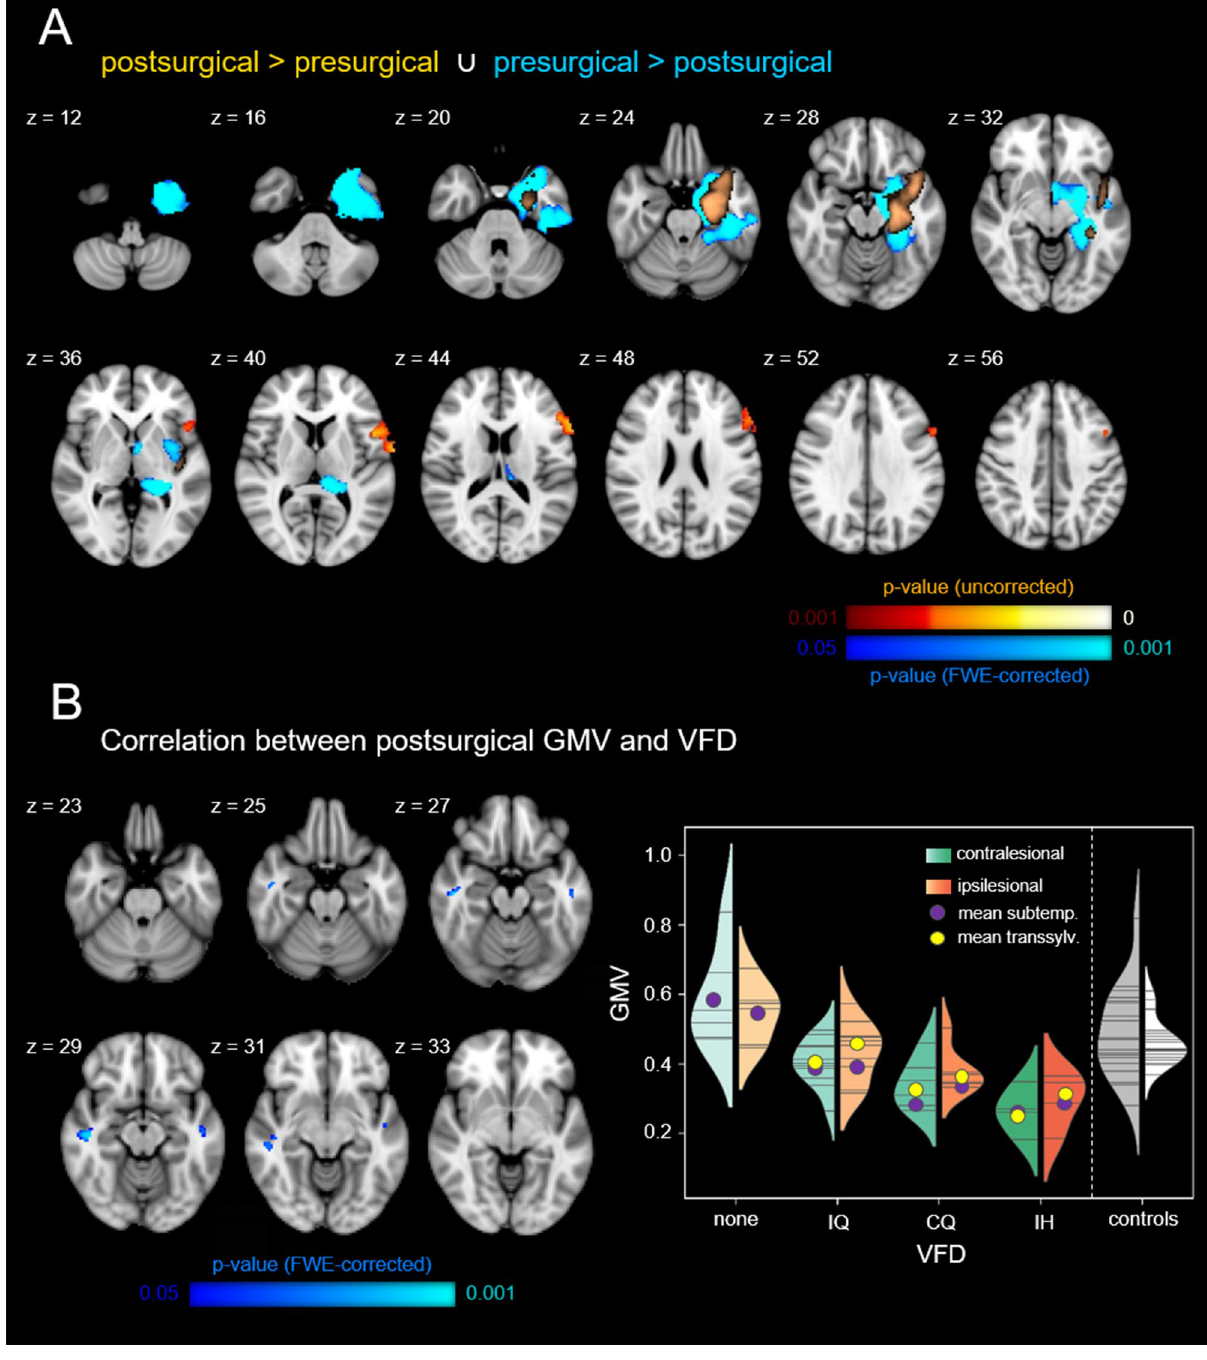
Figure 2. Voxel-based morphometry results. ( A ) Gray matter volume comparison of pre- and postsurgical T1-weighted scans of the transsylvian patient subgroup (FWE-corr. p < 0.05). ( B ) Correlation analysis between postsurgical gray matter volume and visual field deficit: the lower the gray matter volume, the higher the deficit (FWE-corr. p < 0.05). The canonical lesion mask is shown in bronze. Violin plots show the distributions of mean gray matter volumes within the contra- and ipsilesional cluster with each horizontal line representing the readout of one patient/control. z indicates axial level in MNI space. GMV gray matter volume, IQ incomplete homonymous quadrantopia, CQ complete homonymous quadrantopia, IH incomplete homonymous